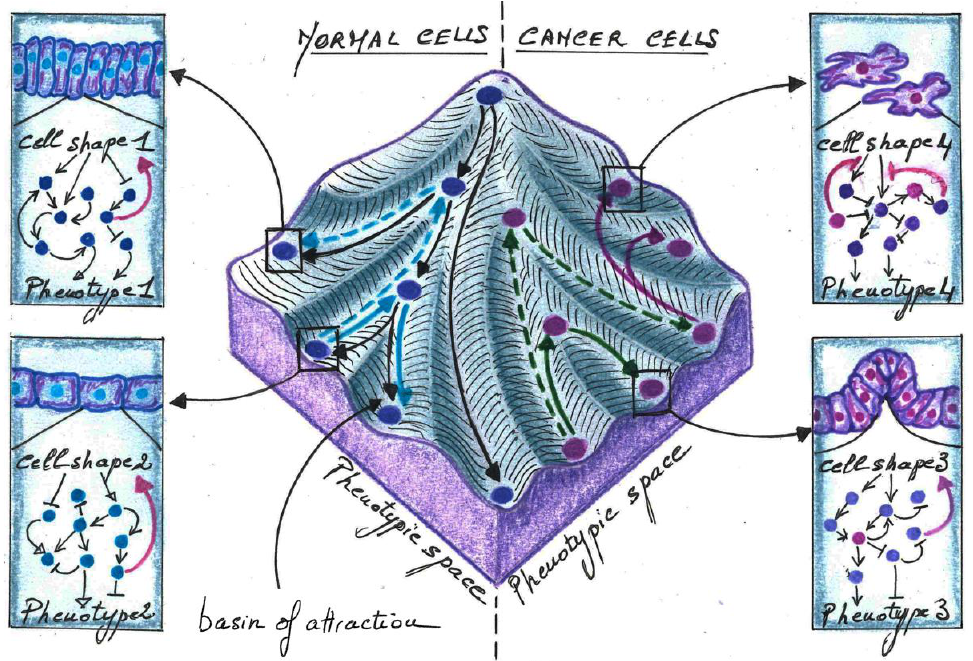
Figure 2. Schematic inspired by Waddington’s epigenetic landscape depicting how cell shape could act as an attractor to control the fate of normal and cancer cells. ( Middle landscape ) Each ball moving into the valleys represents a cell defined by its specific shape and network state represented in the boxes on the left and right of the landscape. The blue balls on the left are normal cells. The pink balls on the right are cancer cells. ( Left ) The shape of normal cells determines which valley will be taken by the cell (black arrows) to reach specific basins of attraction. Cell shape 1 and 2 control specific regulatory interaction networks, which trigger phenotype 1 and 2, respectively. Each regulatory network also stabilizes cell shapes 1 and 2, respectively (pink arrows). Changes in cell shape could trigger cell reprogramming by which a cell climbs up on the landscape and falls down into another basin of attraction (plain blue arrows). These cell shape-dependent phenotypic reversions could rely on the climbing distance and depth of the initial basin of attraction. If it is modest, reversion will be easily attainable (plain blue arrows). However, if it is important, reversion would be less likely (dashed blue arrows). ( Right ) Cells suffering anomalies in their shape (cell shape 3 and 4) and/or acquiring mutations in oncogenic signalling components (pink spots) could climb up the hill and fall down into other basins of attraction (plain green arrow), for example by reacquiring proliferative abilities. To attain basins of attraction that require higher distances to climb up, cells may need to acquire additional cellular alterations (dashed green arrows). During cancer progression, alterations of the regulatory network could inhibit the cell shape-dependent control (pink inhibitions in the upper right box). By escaping the restrictions imposed by cell shape, cells could reach new attractors not attained by normal cells (pink